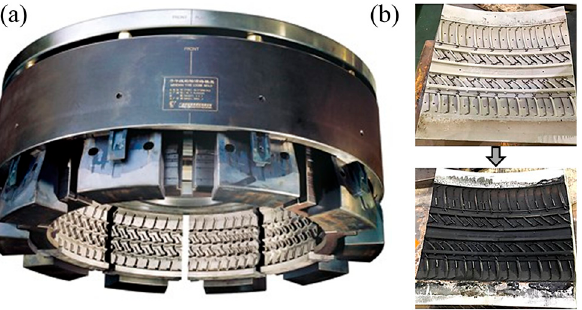
Figure 1. ( a ) Tire mold structure; ( b ) mold surface change after numerous vulcanizations.